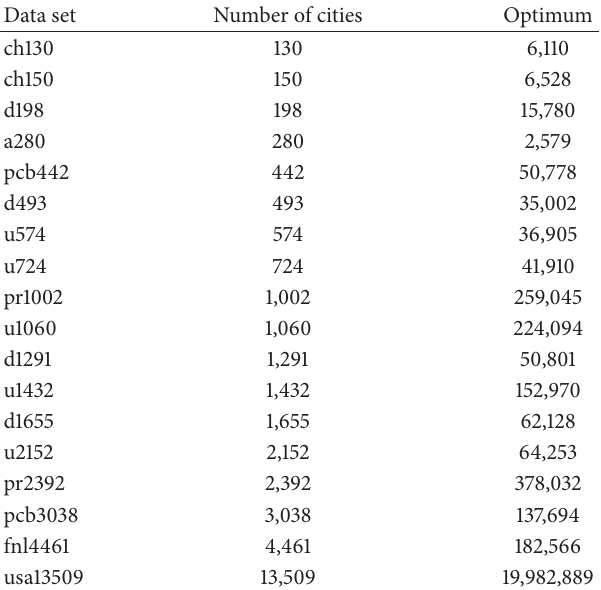
Table 1: Data sets for